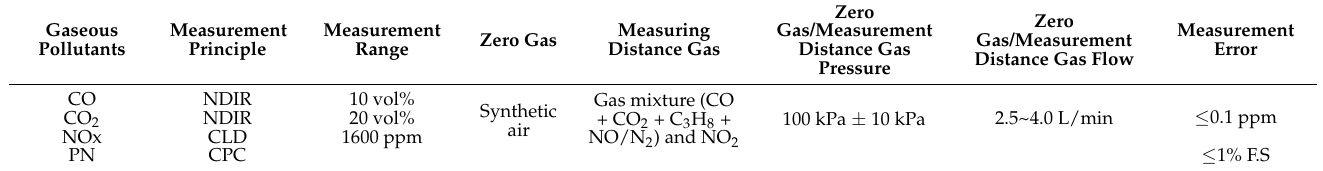
Table 1. OBS-ONE measurement system technical specifications.